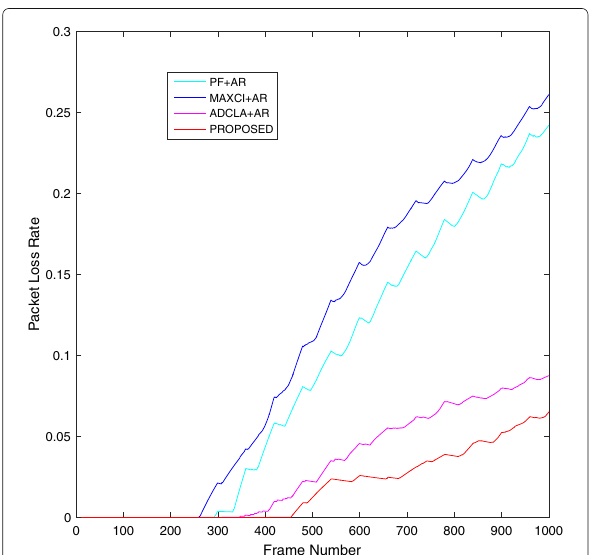
No packet loss means not so serious quality fluctuation